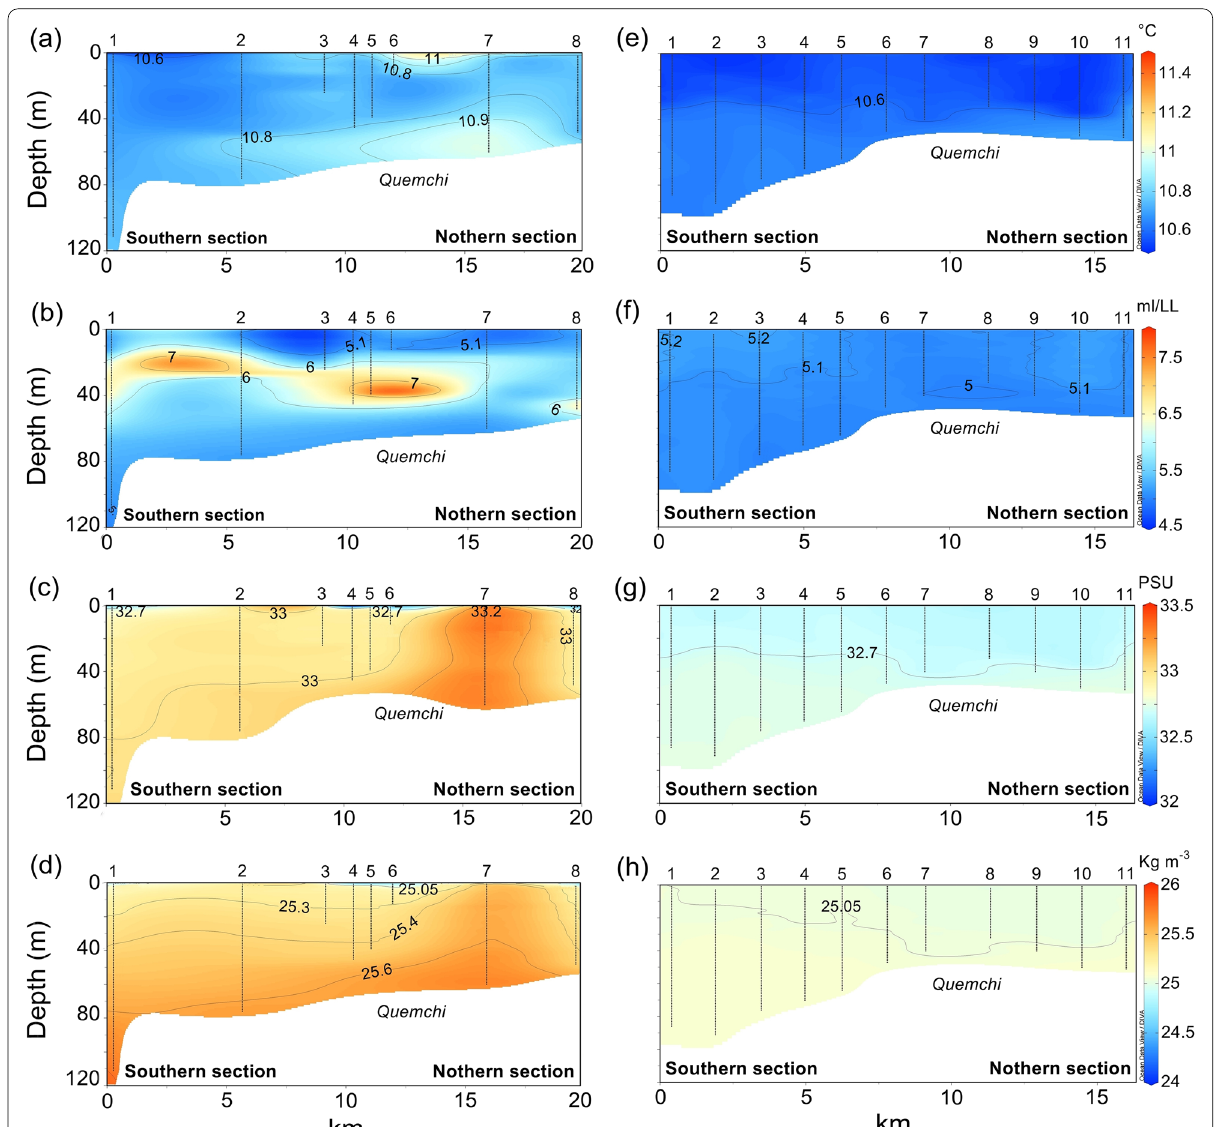
Fig. 11 Along‑channel sections of ( a , e ) temperature, ( b , f ) dissolved oxygen, ( c , g ) salinity and ( d , h ) density. Each section covers the northern and southern sections of the Caucahué Channel. See Fig. 1 for the location of CTDO profiles developed during June 19 (left panel), and 30 (right panel),